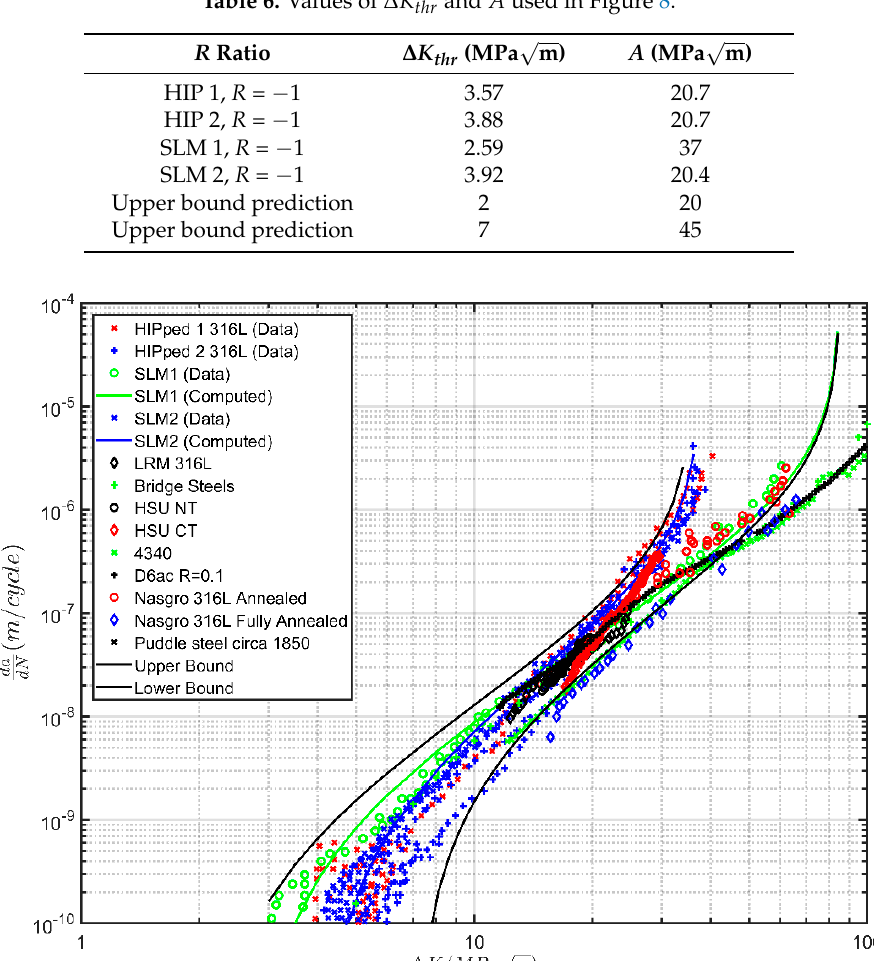
Figure 9. Measured and computed growth in AM 316L specimens.